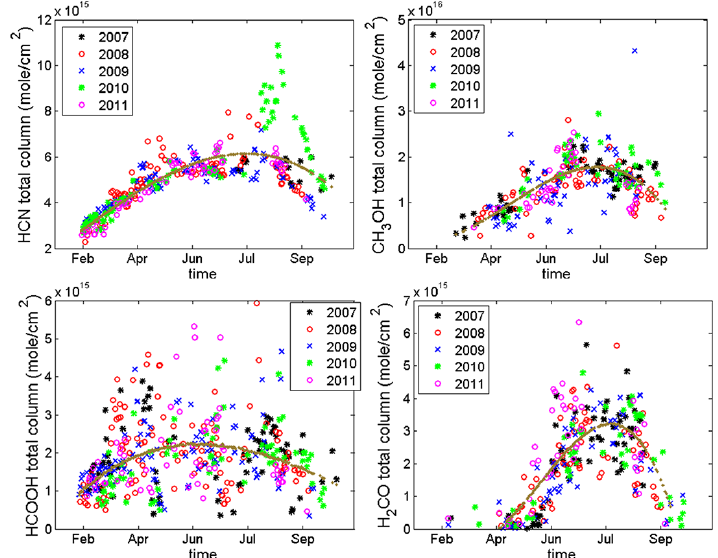
Figure 11. Same as Fig. 10 but for HCN, CH 3 OH, HCOOH and H 2